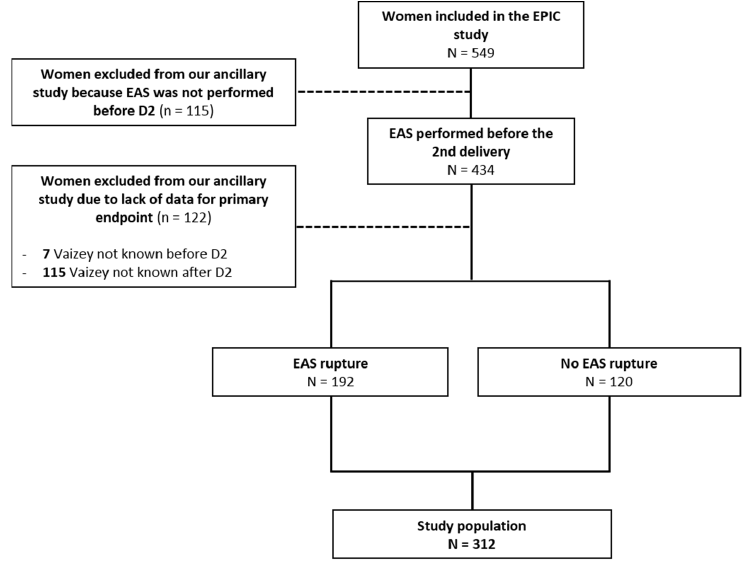
Figure 1. Flow Chart. Table 1. Characteristics of the population.